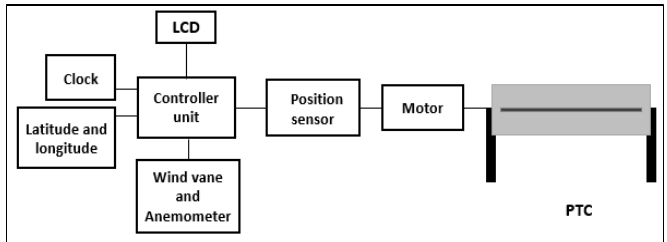
Figure 5: Architecture of the proposed monitoring